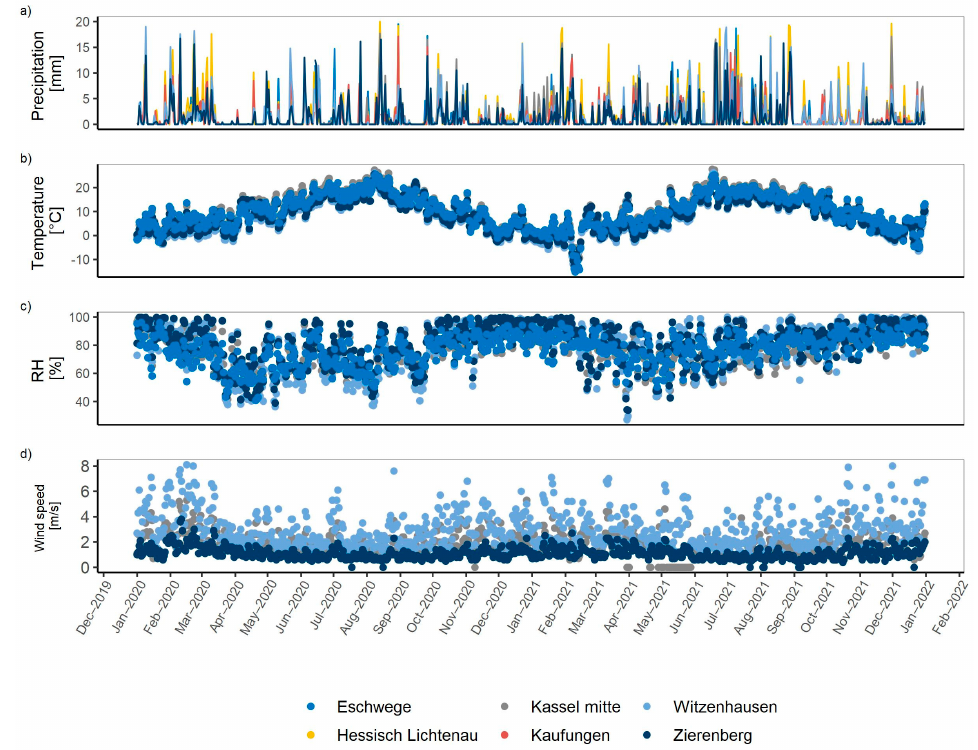
Figure A1. A schematic diagram of a precipitation collector.